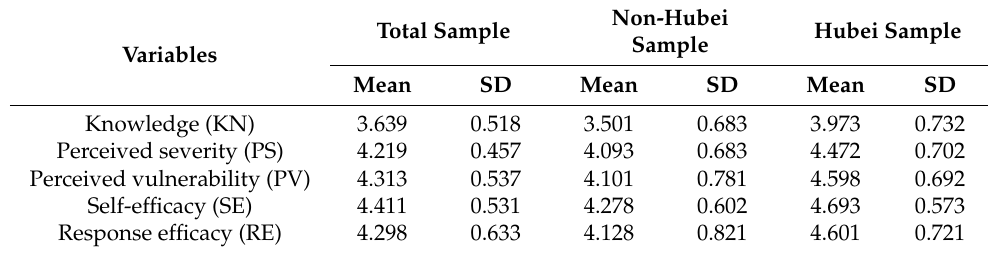
Table 4. Descriptive analysis result of research